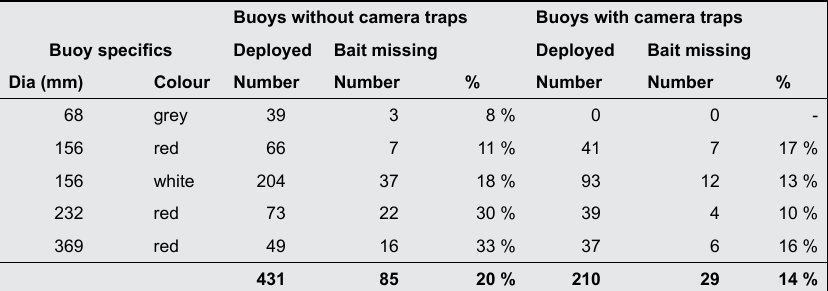
Table 6. Frequency of missing bait in the buoy experiment in relation to whether a camera trap was fitted or